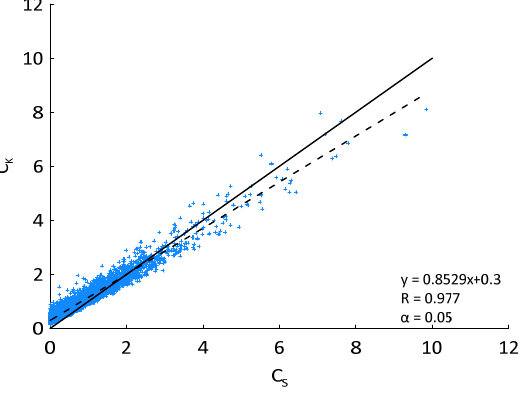
Figure 9. Kurtosis deviation coefficient (C k ) is a function of the skewness deviation coefficient (C S ). The solid line is Y = X, and the dotted line represents the regression line of the whole fog event.